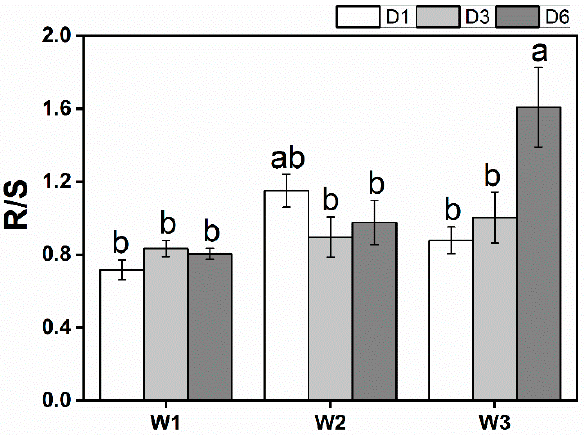
Figure 6. R/S at the end of the experiment in R. pseudoacacia grown under different rainfall intensity and rainfall frequency treatments (mean ± SE, n = 6). Different letters within the same column denote significant differences at p ≤ 0.05 according to Tukey’s − HSD test. W1, W2, and W3: 75%, 55%, and 35% of field capacity, respectively. D1, D3, and D6: every day, every 3 days, and every 6 days of watering, respectively.